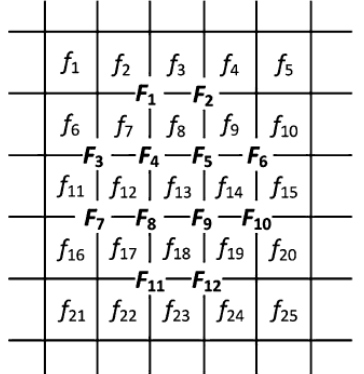
Figure 1. The scheme of the bilinear interpolation discretization mesh for calculating partial derivatives of the solid fraction.